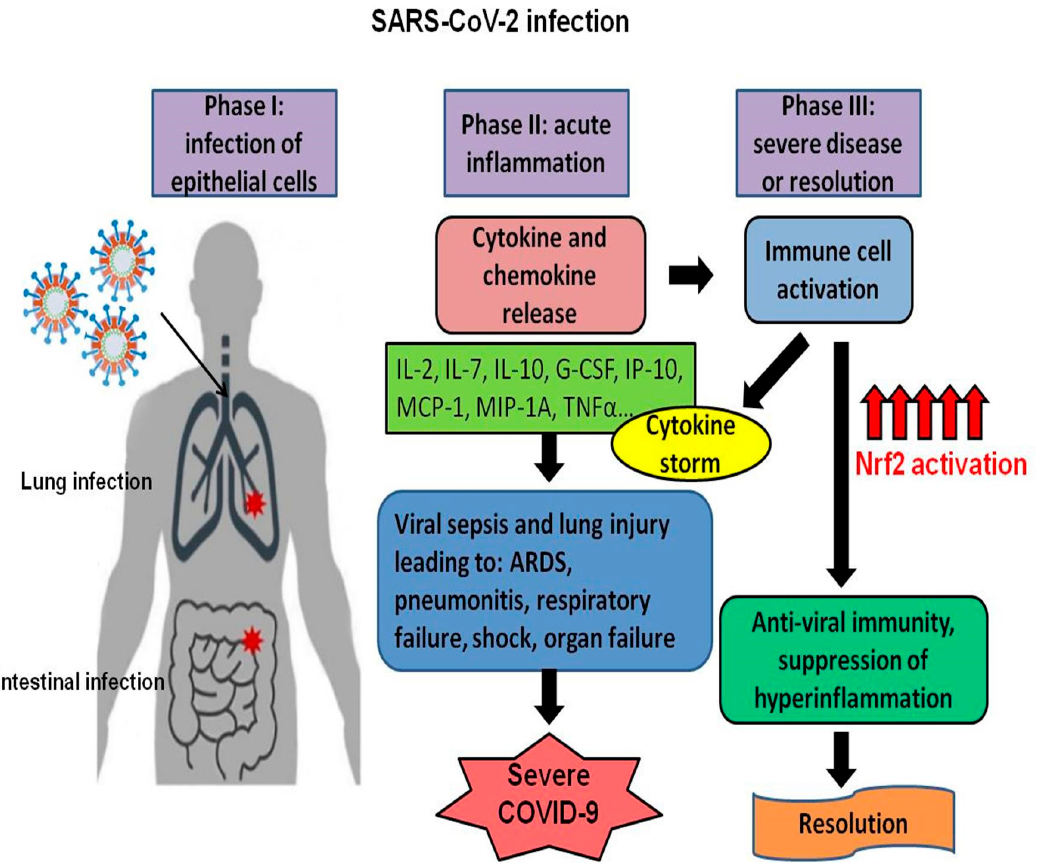
Figure 3. Nrf2 activation limits cytokine production and reduces SARS-CoV-2 infection severity. The diagram shows the phases during SARS-Cov-2 infection and how it can lead to severe disease or patient recovery through the activation of the Nrf2 transcription factor.